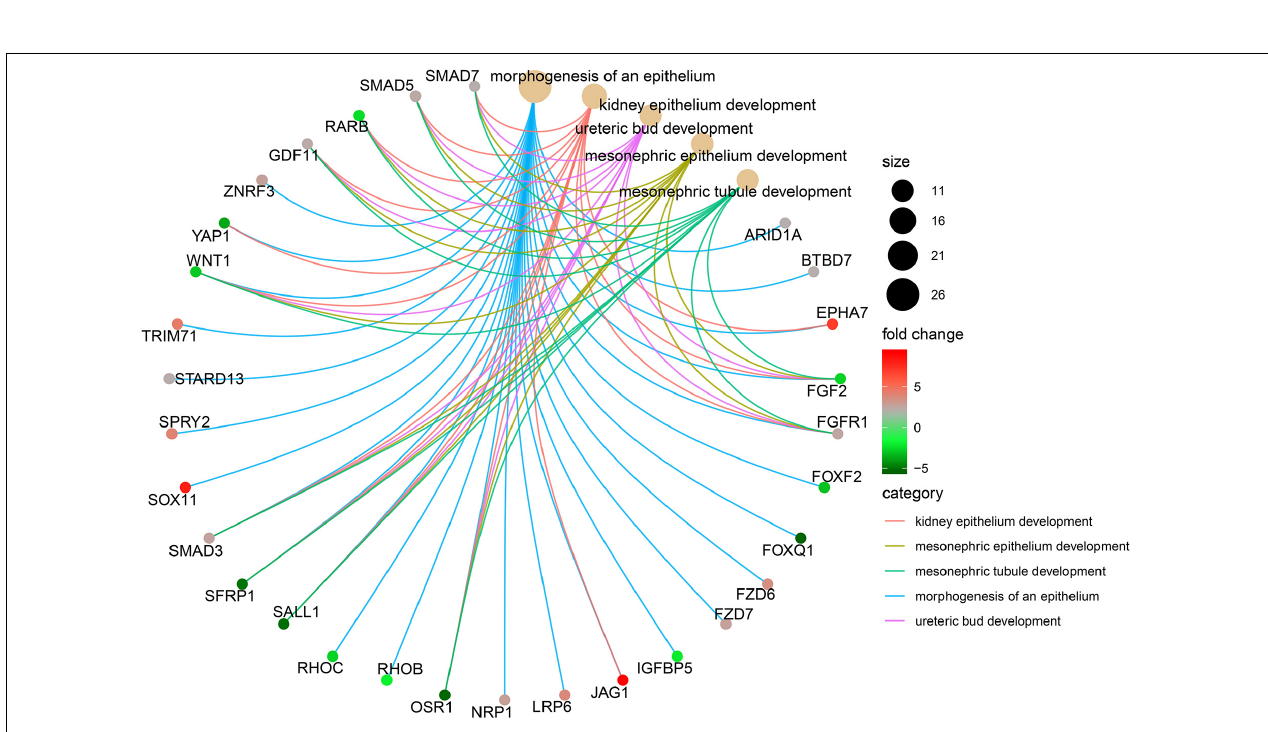
FIGURE 6 | The top five biological processes enriched by DEmRNAs in the ceRNA network. DEmRNAs: Differentially expressed mRNAs.